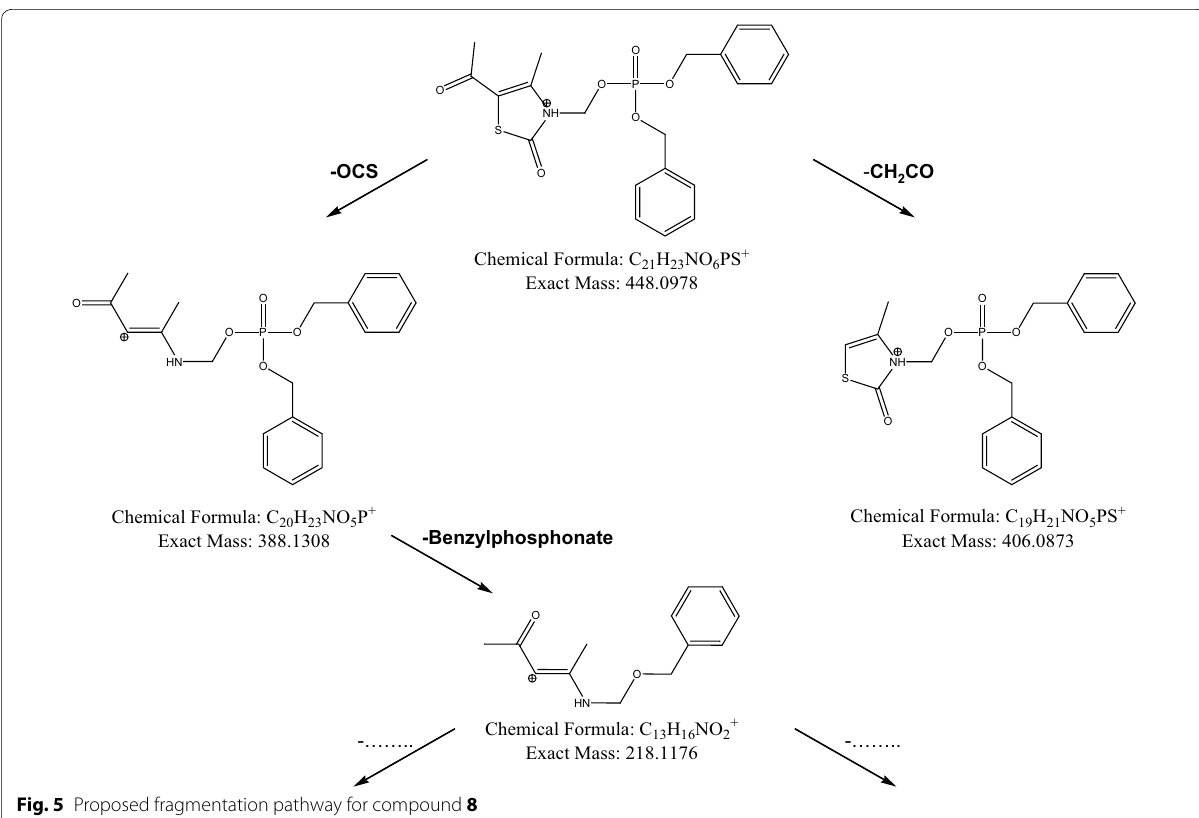
Fig. 5 Proposed fragmentation pathway for compound